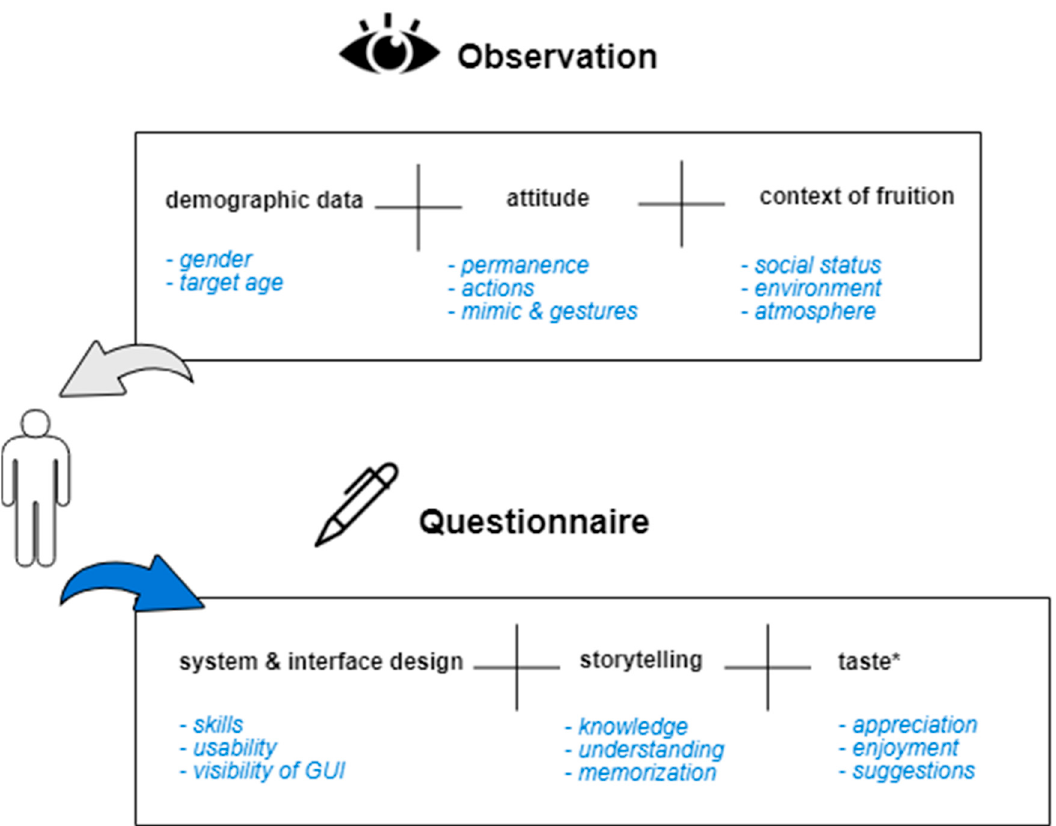
Figure 18. Schema of the units of information recalled by the evaluations. Each unit is developed in specific items to be observed or specific questions to be answered by the visitors.